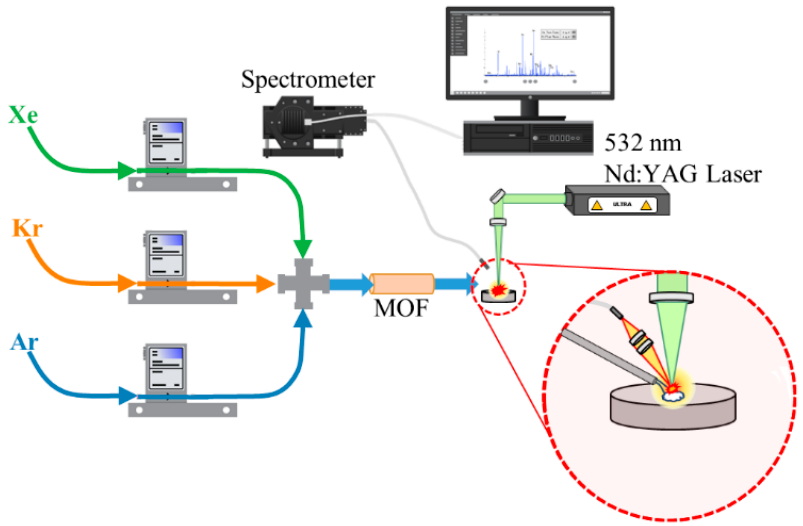
Figure 1. Experimental schematic for LIBS gas analysis with MOF